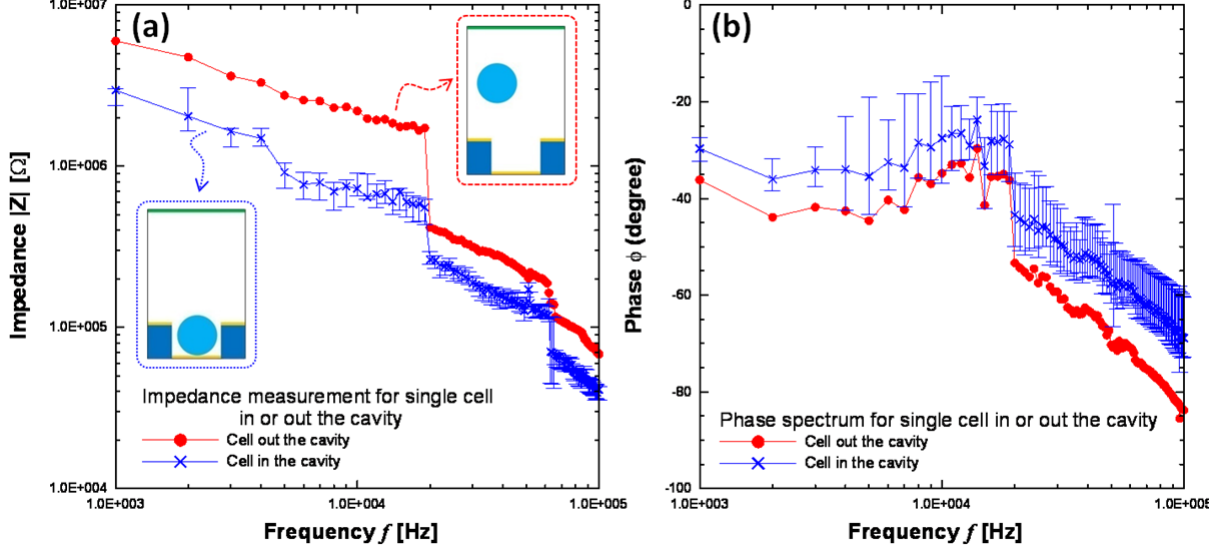
Figure 10. Impedance measurement results for with or without TSGH8301 cell in the micro-cavity array; the applied voltage was 1 V and the frequency range was swept from 1 K to 100 KHz.